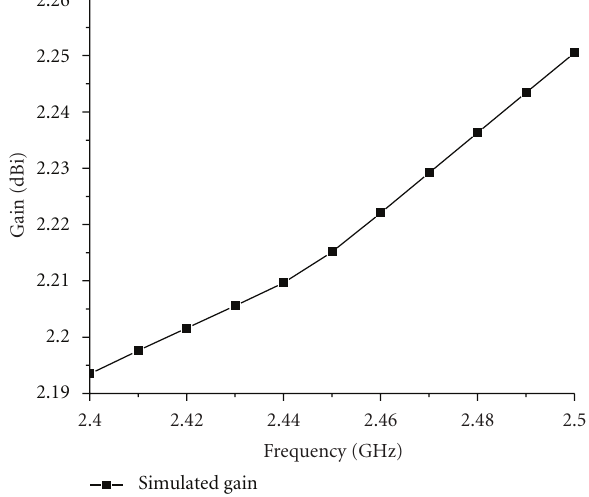
Figure 10: The simulated gain as a function of frequency from 2.4GHz to 2.5